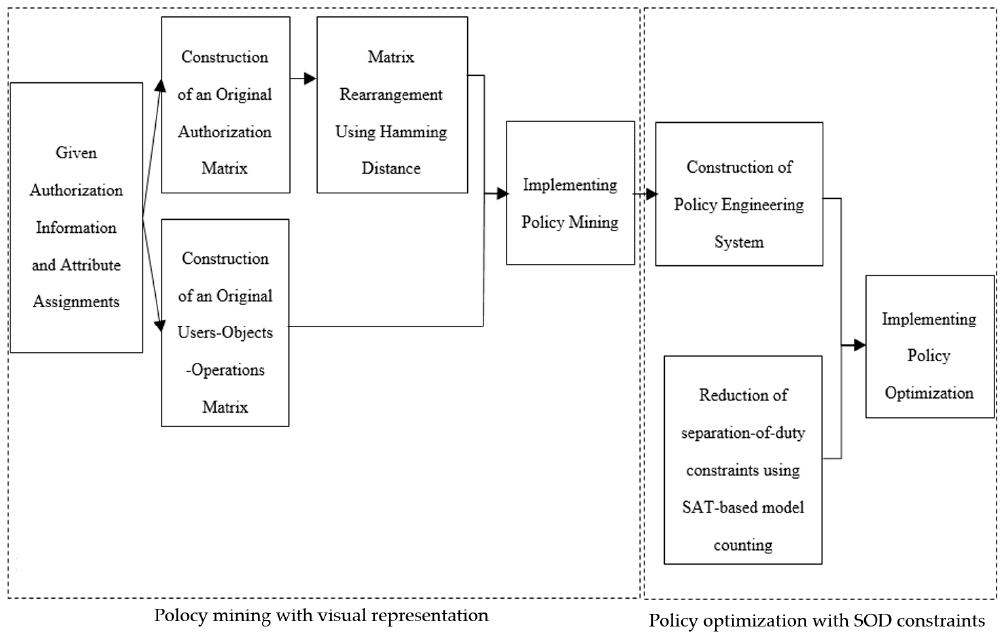
Figure 2. Flow chart of PEO_VR&SOD.